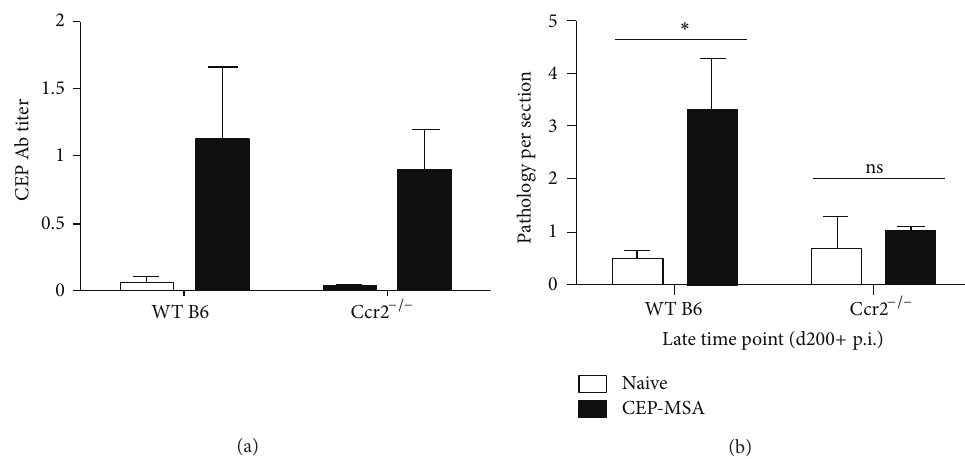
Figure 5: Ccr2 chemokine receptor signaling is required for macrophage recruitment to the outer retina after CEP-MSA immunization. (a) Anti-CEP antibody titers were examined following immunization of WT versus 𝐶𝑐𝑟2 −/− B6 mice ( 𝑛 = 5 ). Na¨ıve mice have no anti-CEP titers. Mean values are shown; error bars represent S.D. (b) Retinal pathology scores for the indicated groups at the late time point (day 200+ p.i.; 𝑛 = 3 ). ( ∗ ) denotes statistically significant difference ( 𝑃 < 0.05 ); ns: not significant. Data from one representative experiment was used for this analysis; similar results were obtained in a separate independent